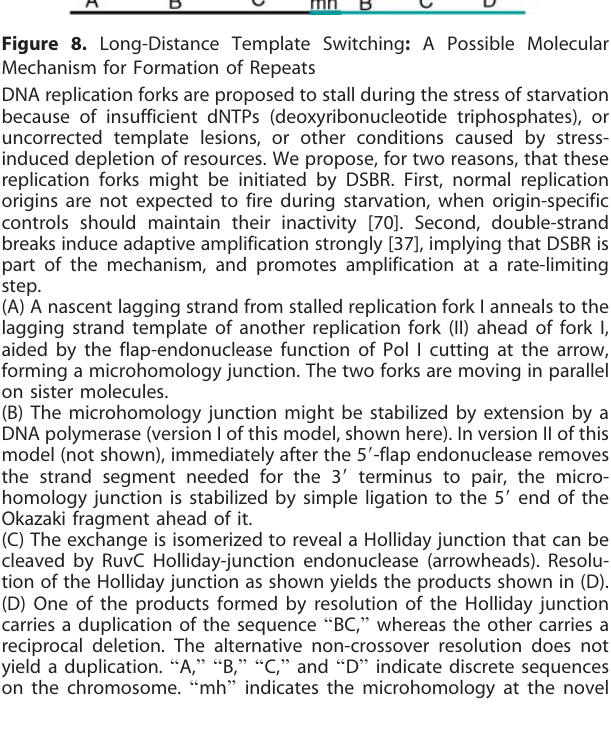
Figure 8. Long-Distance Template Switching : A Possible Molecular Mechanism for Formation of Repeats DNA replication forks are proposed to stall during the stress of starvation because of insufficient dNTPs (deoxyribonucleotide triphosphates), or uncorrected template lesions, or other conditions caused by stress- induced depletion of resources. We propose, for two reasons, that these replication forks might be initiated by DSBR. First, normal replication origins are not expected to fire during starvation, when origin-specific controls should maintain their inactivity [70]. Second, double-strand breaks induce adaptive amplification strongly [37], implying that DSBR is part of the mechanism, and promotes amplification at a rate-limiting step.